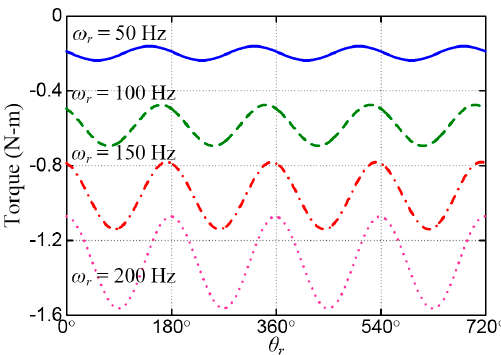
Figure 6. Braking torque produced by the induced current at different rotor speed.